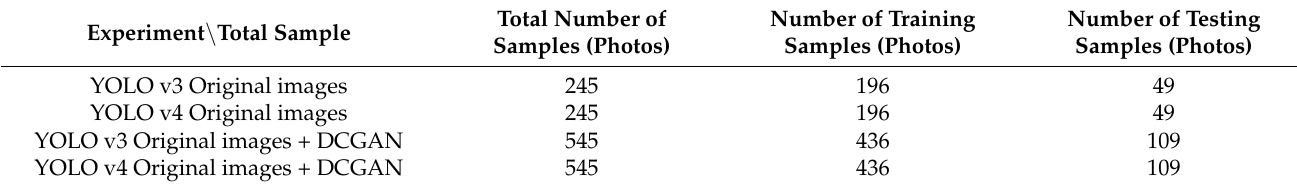
Table 2. Dataset details used to evaluate image sets and